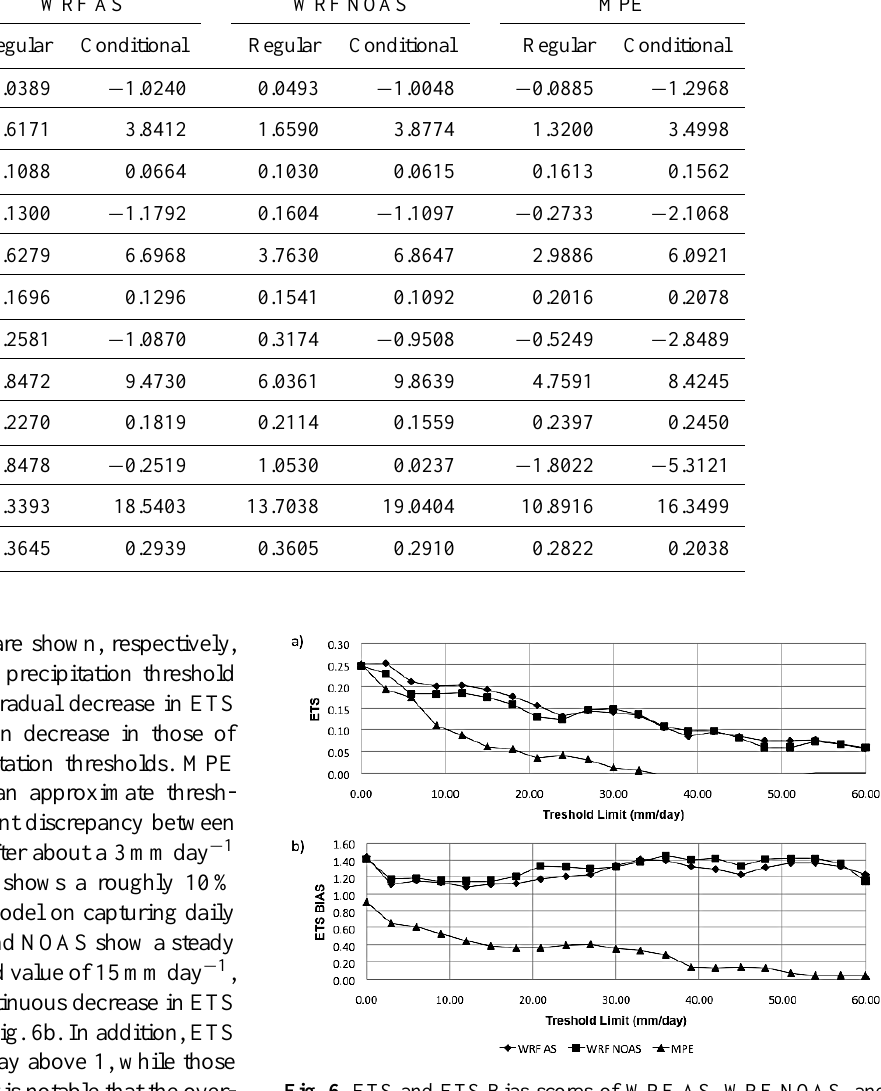
Fig. 6. ETS and ETS Bias scores of WRF AS, WRF NOAS, and MPE are shown, respectively, in (a) and (b) for different daily pre- cipitation threshold